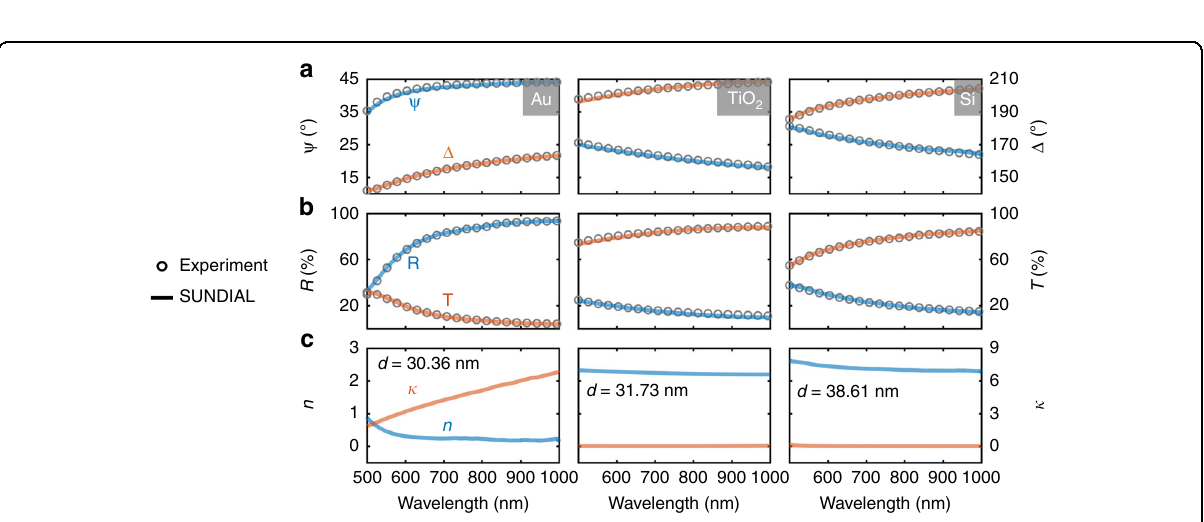
Fig. 3 Results of SUNDIAL on Au, TiO 2 , and Si. a , b Measured Ψ , Δ , R , and T spectra are presented by empty circles. Model-generated spectra, drawn as solid lines, are calculated using ( n , κ , d ) by the SUNDIAL method and forward functions F and G . Each column corresponds to a material. c The ( n, κ , d ) retrieved by SUNDIAL